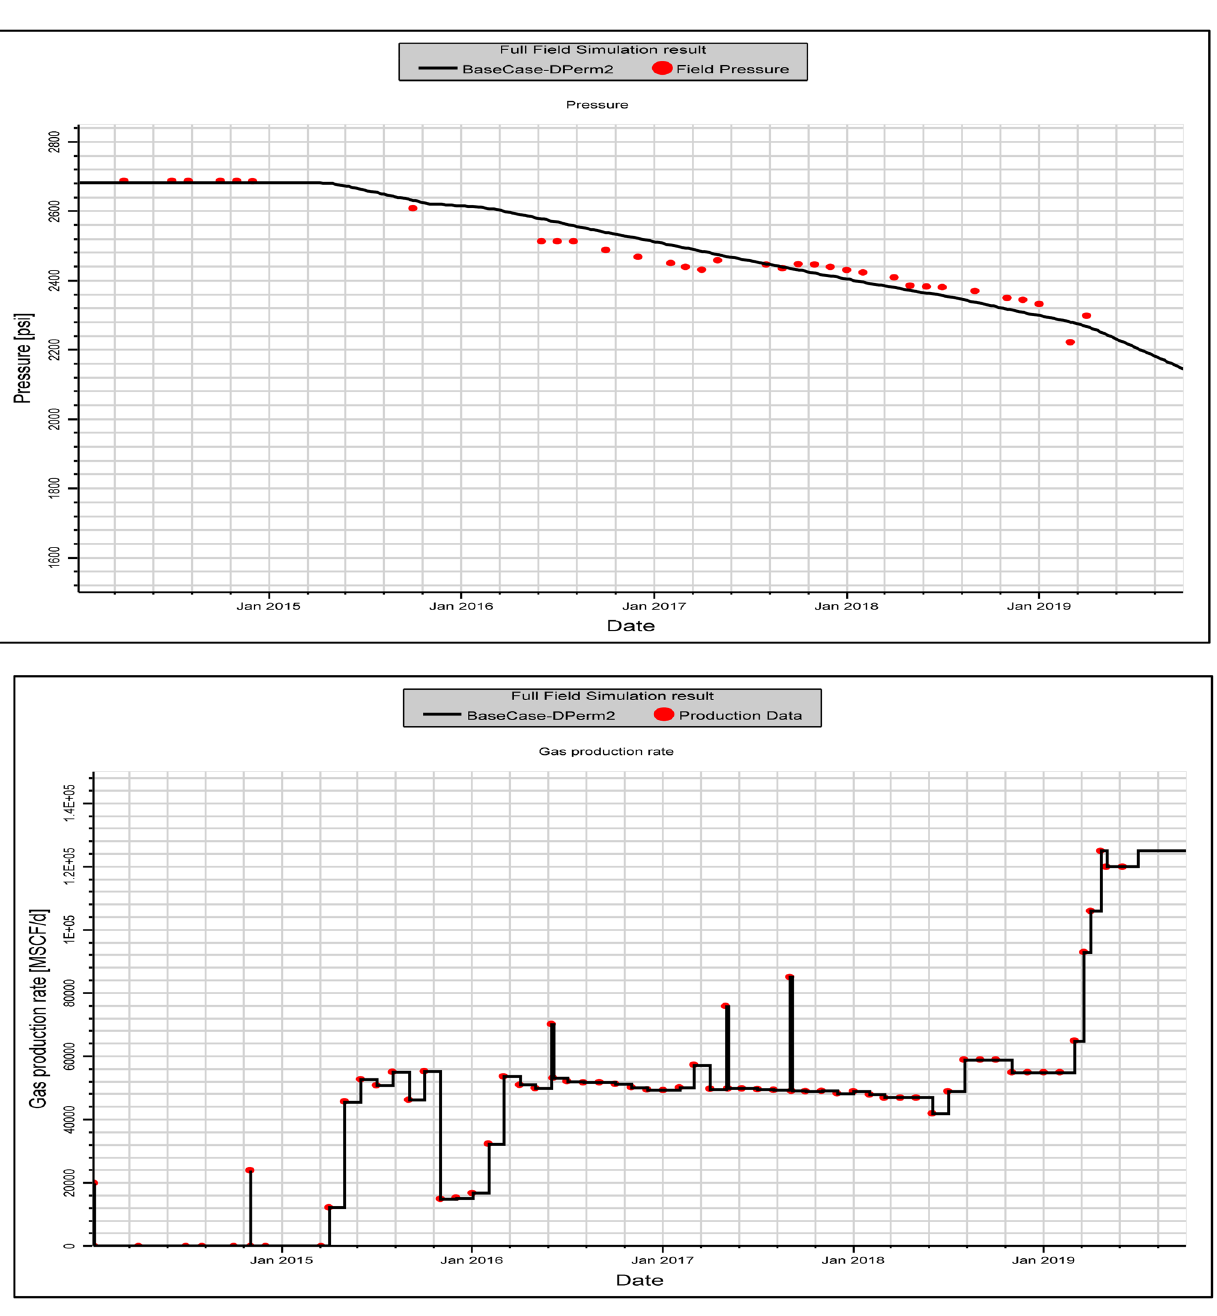
Fig. 15 Initial simulation result after applying potential